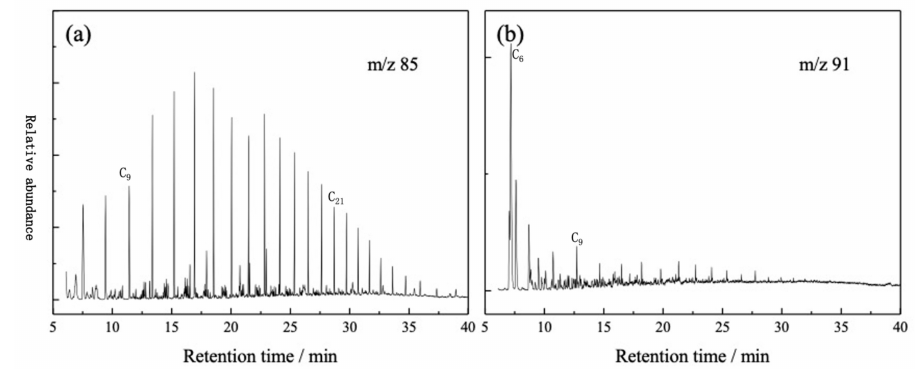
Figure 5. Spectrum of n-alkanes and aromatic hydrocarbons. ( a ) The ion current spectra with m / z of 85; ( b ) The ion current spectra with m / z of